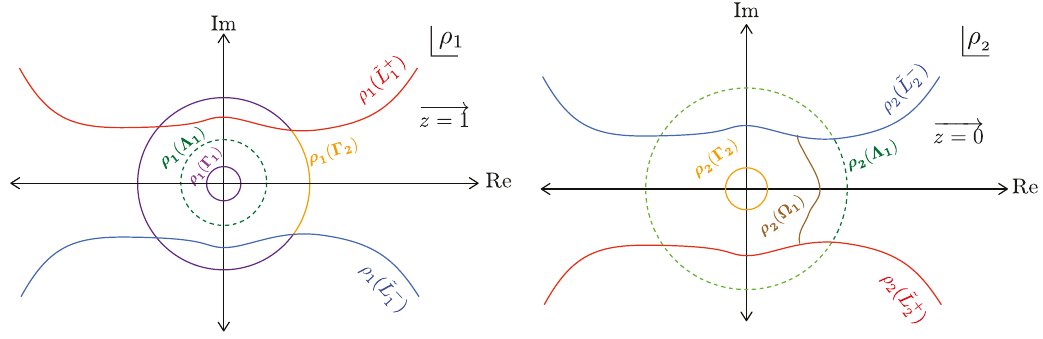
Figure 4 . The illustration of the geometry described in the argument above on the ρ 1 -plane (left) and ρ 2 -plane (right). Here the line singularity Λ 1 is shown with dark green, while the geodesic Ω 1 is shown with